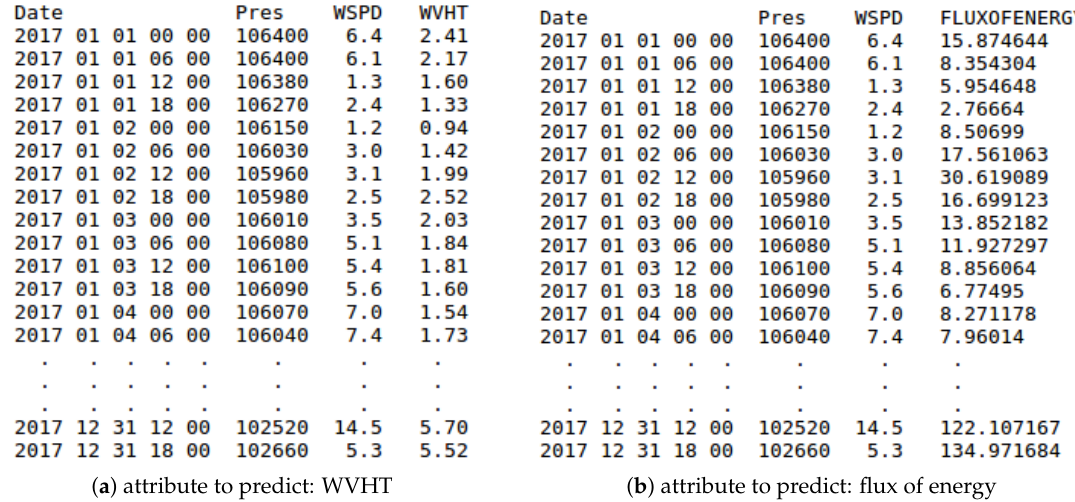
( a ) attribute to predict: WVHT ( b ) attribute to predict: flux of energy Figure 8. Example of data integration for Direct matching